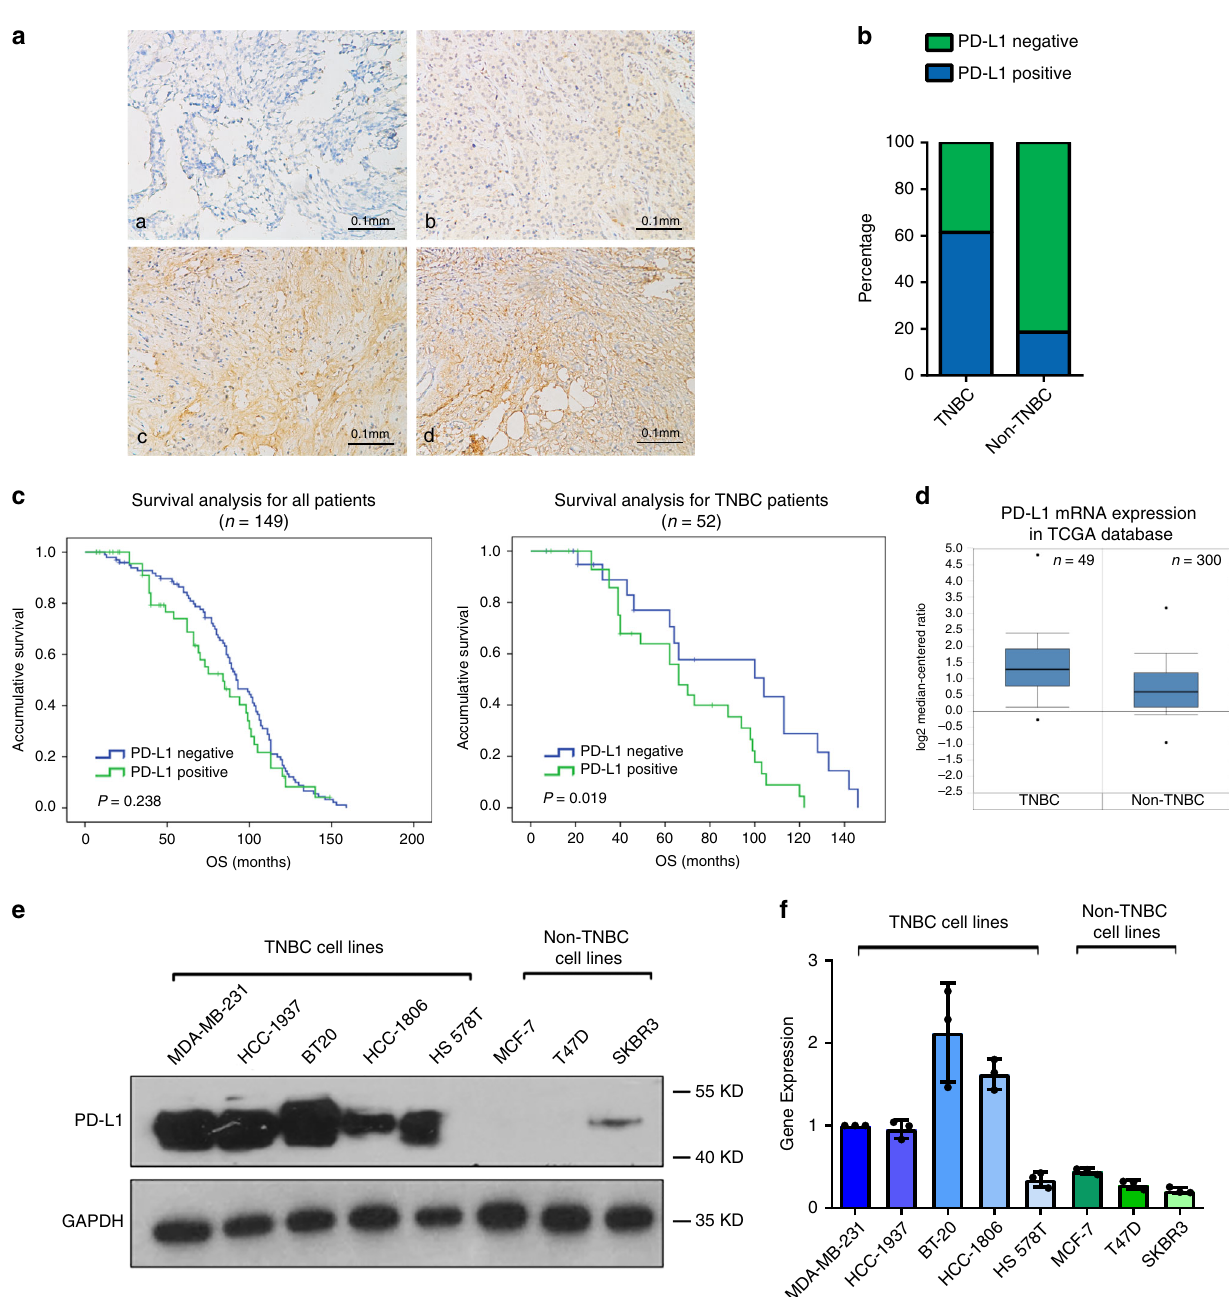
Fig. 1 TNBCs have higher PD-L1 expression. a Representative images of immunohistochemical (IHC) staining of PD-L1 in 149 breast cancer tissues ( a , PD- L1 negative; b – d , PD-L1 positive). b PD-L1 positive rate in 52 TNBC and 97 non-TNBC patient samples. Tow-side Pearson Chi-square analysis was used to determine the correlation. c Kaplan – Meier analysis for all breast cancer subtypes and TNBC based on PD-L1 expression. Data was analyzed by log-rank test. d PD-L1 mRNA expression in TNBC and non-TNBC in TCGA database ( P < 0.0001). For TNBC group, maximum = 4.806, median = 1.28, minimum = − 0.265, upper bound (75th percentile) = 1.913, lower bound (25th percentile) = 0.766. For non-TNBC group, maximum = 3.176, median = 0.603, minimum = − 0.973, upper bound (75th percentile) = 1.173, lower bound (25th percentile) = 0.129. e Western blot analysis of PD-L1 in TNBC cell lines (MDA-MB-231, HCC1937, BT20, HCC1806, and HS578T) and non-TNBC cell lines (MCF-7, T47D, and SKBR3). f RT-qPCR analysis of PD-L1 mRNA in TNBC and non-TNBC cell lines. Data were presented as mean ± s.d. of three independent experiments. Source data are provided as a Source Data fi